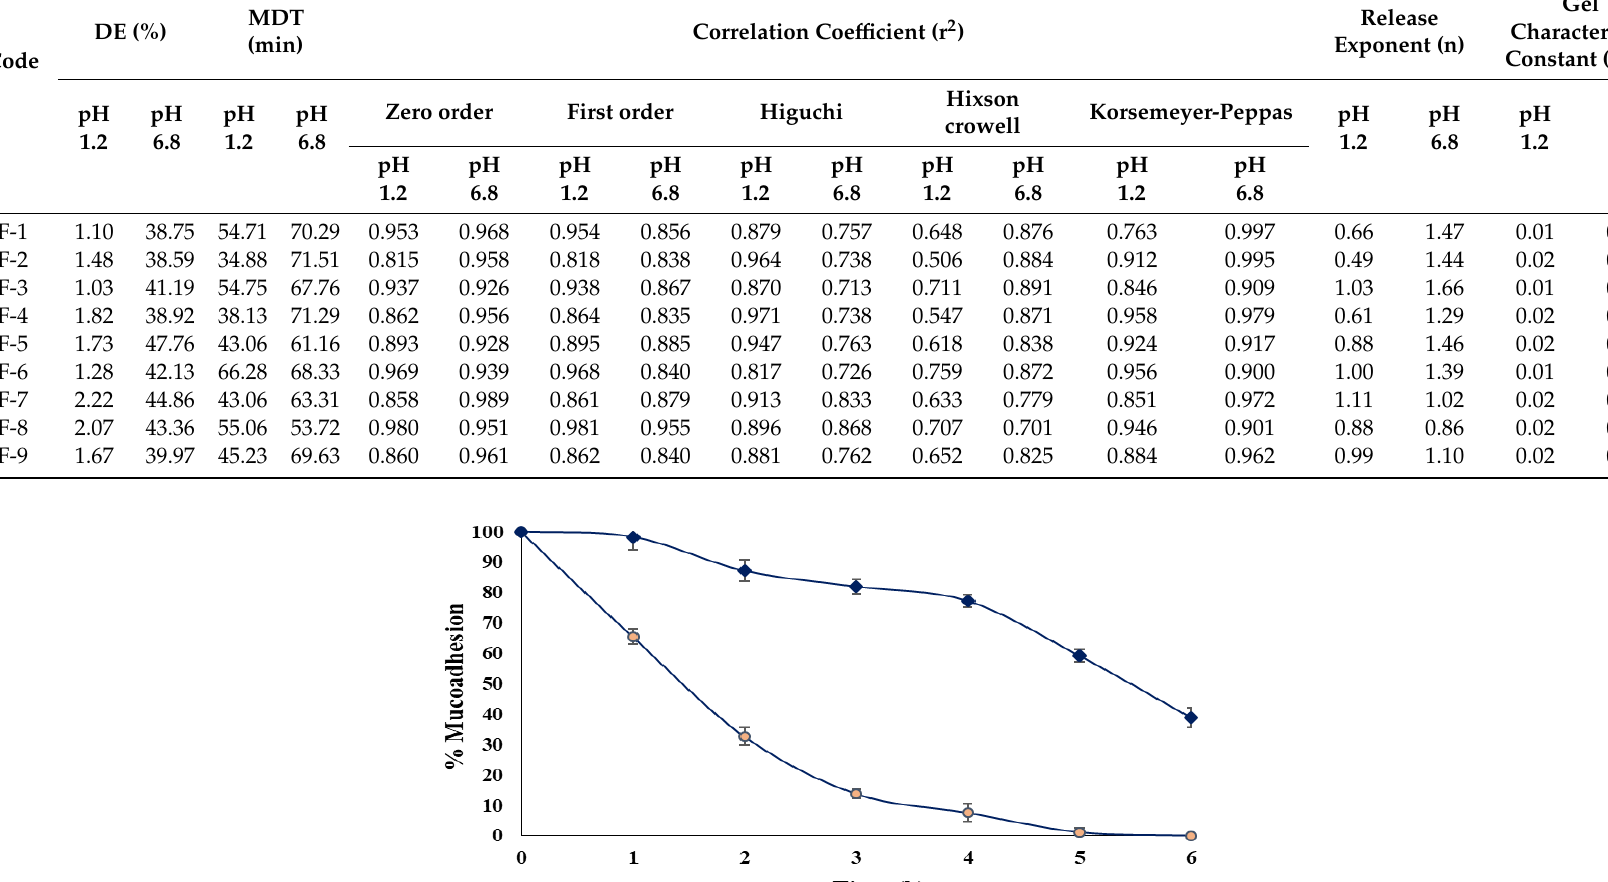
Table 4. Dissolution e ffi ciency (DE), mean dissolution time (MDT) and results of the drug release profile fitting to kinetic models of various beads (F-1–F-9).